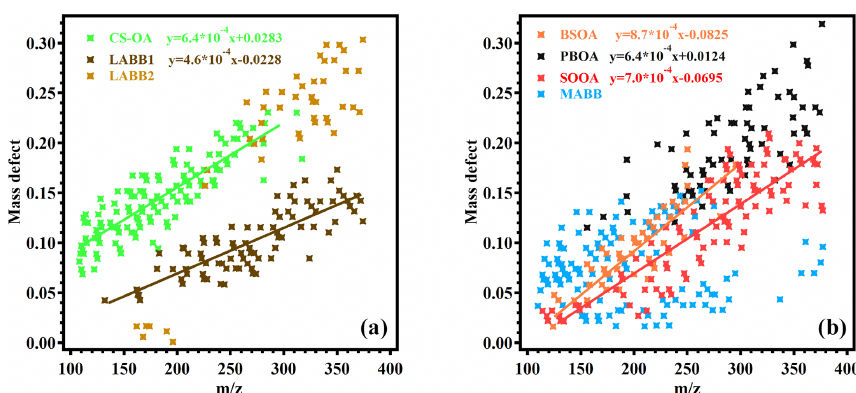
Figure 6. Mass defect plots of factor-specific ions (identified from the cluster analysis) for selected EESI-TOF POA (a) and SOA (b)